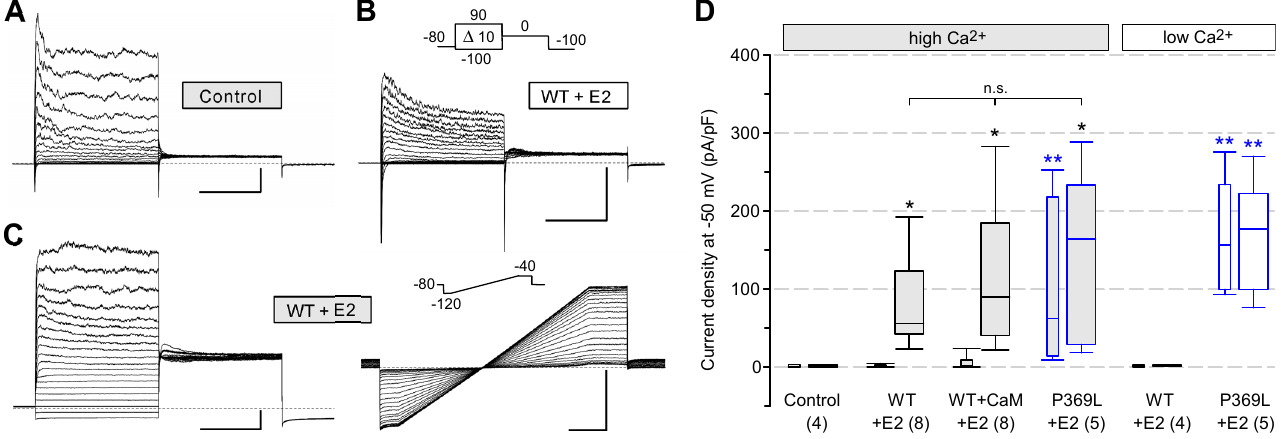
Figure 7. High intracellular Ca 2+ activates WT Q1E2 channels expressed in GH 3 /B 6 anterior pituitary cells. Whole-cell recordings were performed in native GH 3 /B 6 somato-mammotroph cells (Control) or cells overexpressing KCNE2, together with either WT or P369L-KCNQ1. In one set of WT KCNQ1 experiments, CaM was additionally co-expressed. The ICS contained either a high (5 µ M) or a low (20 nM) Ca 2+ concentration. ( A ) Family of current traces recorded from a native GH 3 /B 6 cell with the pulse protocol shown in ( B ) using high-Ca 2+ ICS. ( B ) Membrane currents recorded with low-Ca 2+ ICS in a cell overexpressing WT Q1E2. Peak Na + inward currents are truncated. ( C ) Membrane currents recorded with high-Ca 2+ ICS in a cell overexpressing WT Q1E2. Prior to the IV protocol (family of current traces, left panel), activation of WT Q1E2 channels was traced for 5 min by applying a voltage ramp ranging from − 120 mV to − 40 mV every 2 s. An overlay of the first and then every fifth current trace is shown (right panel). Scale bars in ( A – C ) denote 1 nA and 100 ms. ( D ) Boxplot of initial current densities at − 50 mV (thin boxes) and maximal current densities after 4 − 5 min in the whole-cell configuration (broad boxes). Black asterisks directly above a box indicate significant differences to the control data obtained with high-Ca 2+ ICS in native GH 3 /B 6 cells. Blue asterisks indicate significant differences compared to the respective WT Q1E2 data recorded with the same ICS. ** p < 0.01; * p < 0.05; n.s., not significant. Numbers of experiments are given in